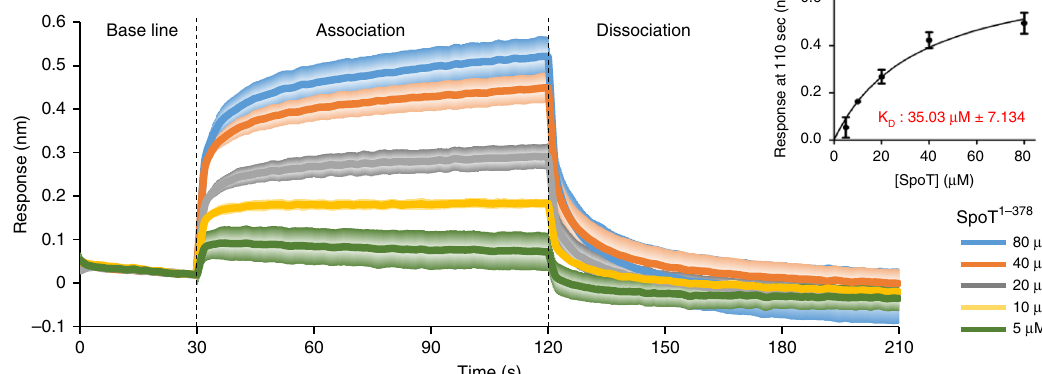
Fig. 7 YtfK can interact with the catalytic domain of SpoT in vitro. BioLayer interferometry assay. The graph shows the subtracted reference binding responses during the association and dissociation of SpoT on YtfK. For kinetic titration analysis: increasing concentrations of recombinant SpoT 1 – 378 (5 – 80 μ M) were bounded to biotinylated YtfK (2.5 µ M). Error bars (presented in degraded colors) indicate the standard deviations of averages of three experiments. The inset graph shows the speci fi c BlI response (nm) 10 s before the end of association as a function of SpoT 1 – 378 concentration (5 – 80 µ M). Each data point (mean + / − SD) is the result from triplicates studies used to determine dissociation constant K D . Source data are provided as a Source Data fi